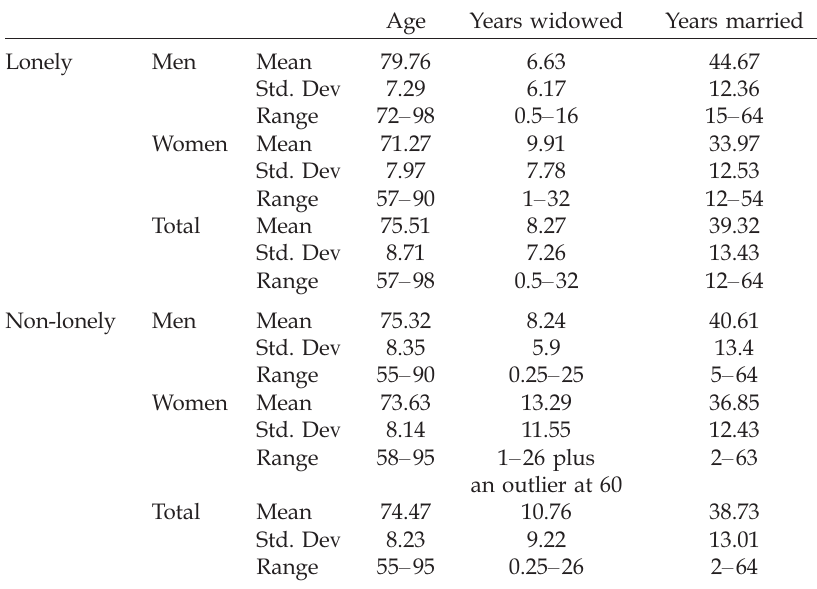
Table 1. Demographic information distinguishing between sub-groups of lonely and those not spontaneously reporting loneliness Age Years widowed Years married Lonely